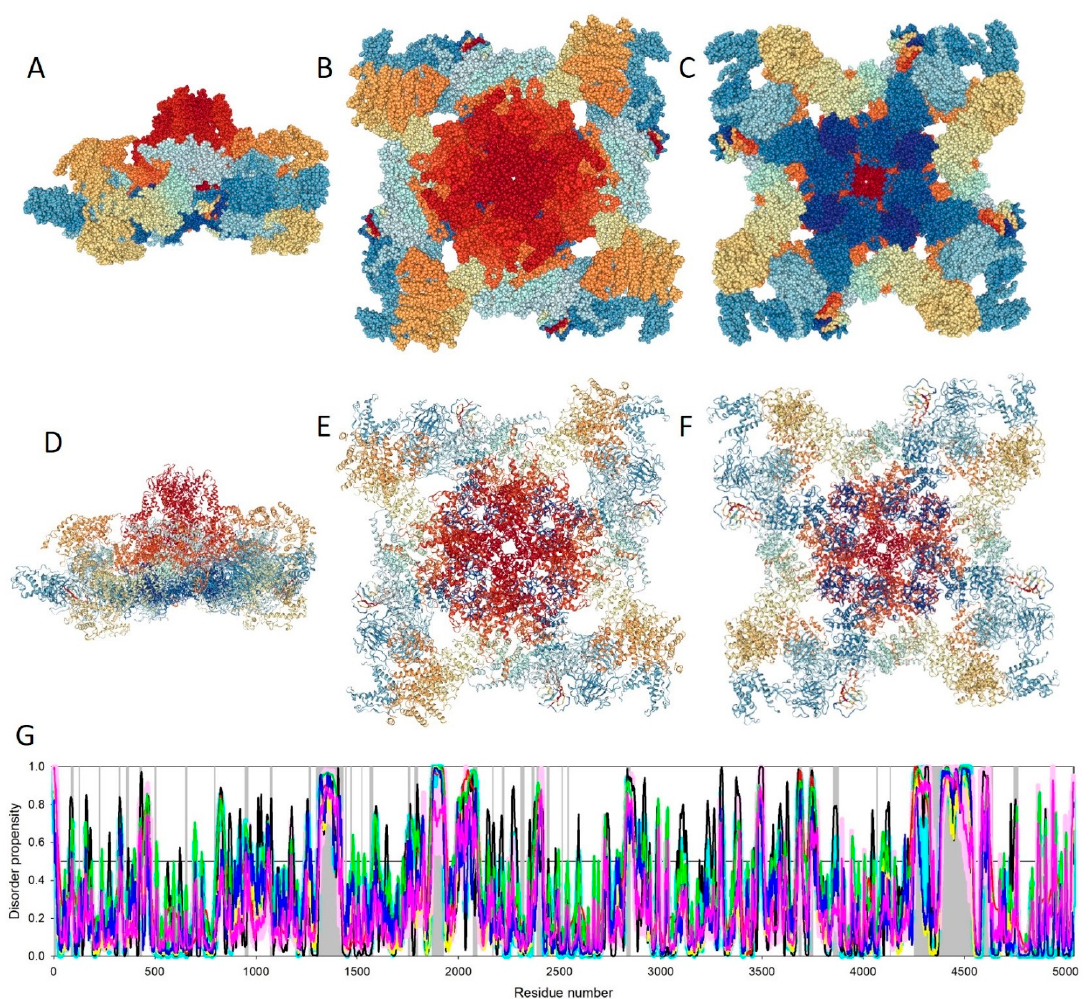
Figure 2. Structural characterization of rabbit RyR1 by single-particle cryo-EM (protein data bank (PDB) ID: 5T15) and a set of commonly used predictors of intrinsic disorder. ( A ). Side view of the channel in a space-fill representation. ( B ). Membrane-side view of the channel in a space-fill representation. ( C ). Cytoplasmic-side view of the channel in a space-fill representation. ( D ). Side view of the channel in a cartoon representation. ( E ). Membrane-side view of the channel in a cartoon representation. ( F ). Cytoplasmic-side view of the channel in a cartoon representation. In these plots, the chains are colored using the rainbow schema of the PDB 3D-viewer (where the N- and C-terminal regions are colored blue and red, respectively). ( G ). Evaluation of the intrinsic disorder propensity of rabbit RyR1 (UniProt ID: P11716) by a set of commonly used disorder predictors. Presented disorder profiles were generated by PONDR-FIT (pink curve), PONDR ® VLXT (black curve), PONDR ® VSL2 (green curve), and PONDR ® VL3 (red curve) [106–111], as well as two tools from the IUPred web server for predicting short and long disordered regions (blue and yellow curves, respectively) [112]. The dark cyan dashed line shows the mean disorder propensity calculated by averaging the disorder profiles of the individual predictors. The light pink shadow around the PONDR ® FIT shows error distribution, whereas the light cyan shadow around the mean disorder curve reflects the distribution of standard deviations. Light gray bars show positions of structurally uncharacterized regions. In these analyses, the predicted intrinsic disorder scores above 0.5 are considered to correspond to the disordered residues / regions, whereas regions with disorder scores between 0.2 and 0.5 are considered